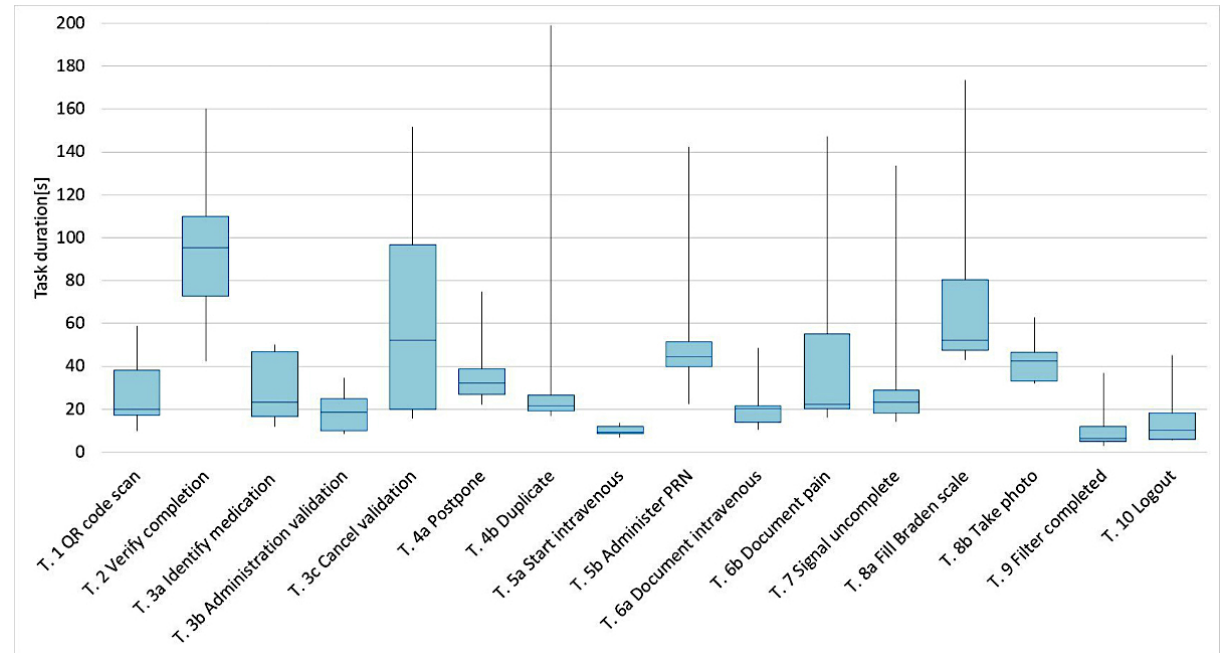
Figure 6. Boxplot of time spent on each